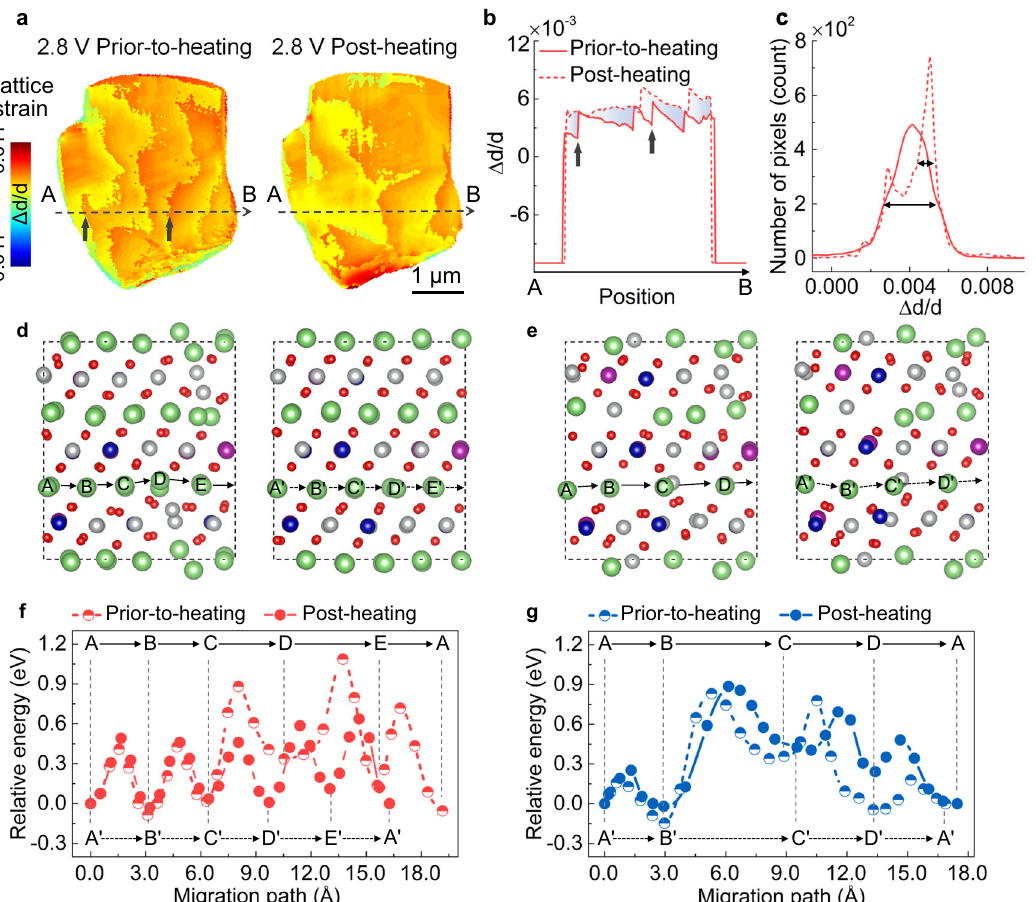
Fig. 4 The lattice strain evolution of the single-crystalline NMC622 particle. a The lattice strain map of d-spacing for 2.8 V particles before and after thermal treatment. b The line pro fi les from points A to B as illustrated in ( a ). c The relative probability distribution of the lattice strain is displayed in ( a ). The curve name in ( c ) is identical to ( b ). The NMC supercell at 2.8 V ( d ) and 4.9 V ( e ) before and after thermal treatment. The left and right panels in ( d and e ) represent before and after thermal treatment, respectively. The green, red, gray, blue, and purple spheres represent Li, O, Ni, Co, and Mn atoms, respectively. Energy pro fi les at 2.8 V ( f ) and 4.9 V ( g ) along the two Li migration pathways before and after thermal treatment,